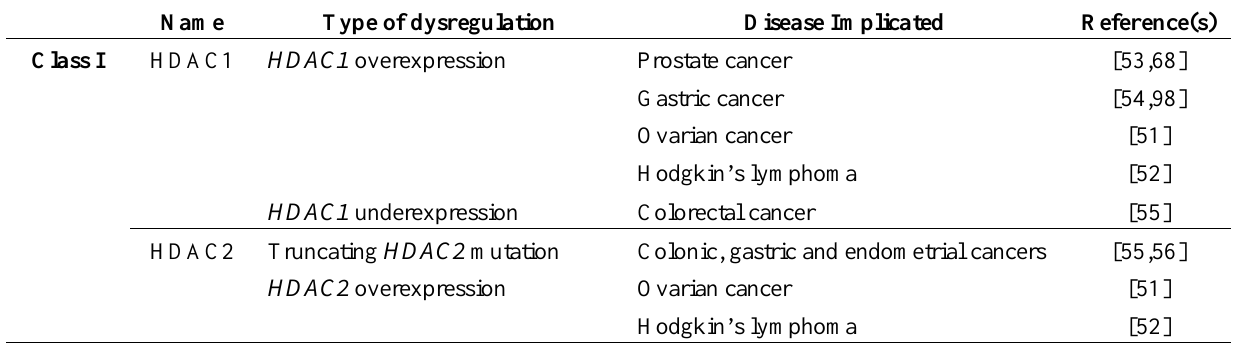
Table 2. Effect of HDAC dysregulation on human disease (adapted from